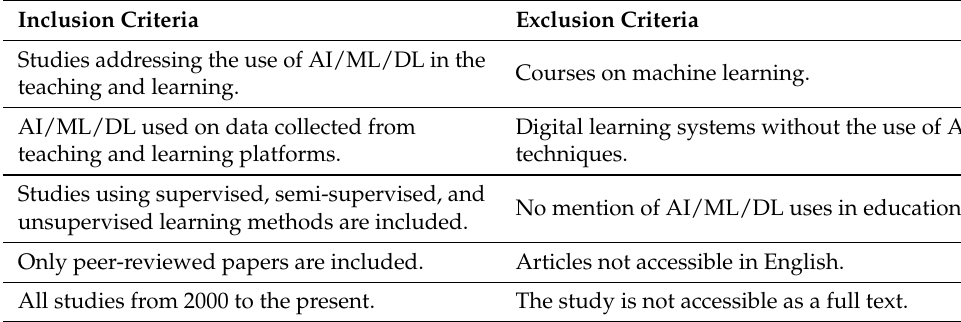
Table 2. Inclusion/exclusion criteria.